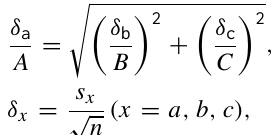
uncertainty for the PM 1 / PM 10 and of PM 2 . 5 / PM 10